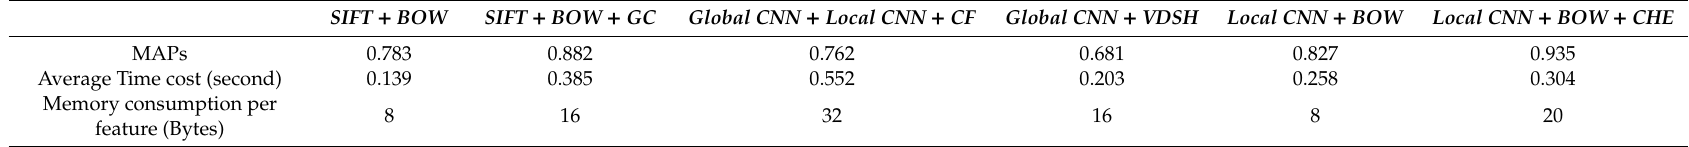
Table 1. Comparison between di ff erent methods on the Copydays dataset.